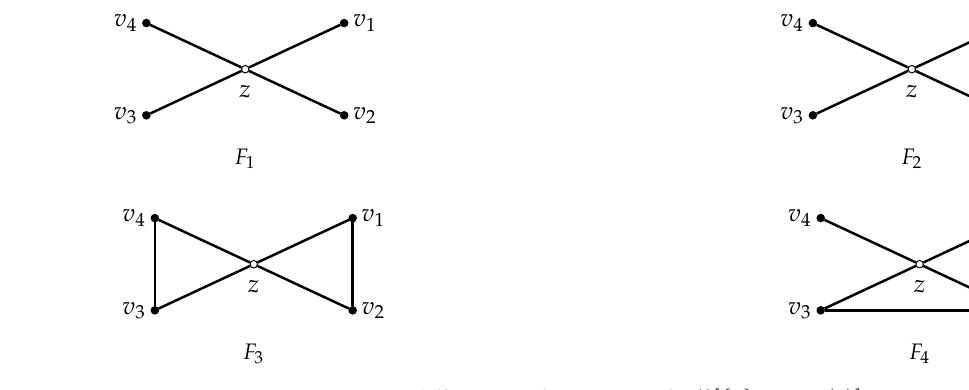
Figure 2. Four different configurations of H × [ { z } ∪ N H × ( z )]